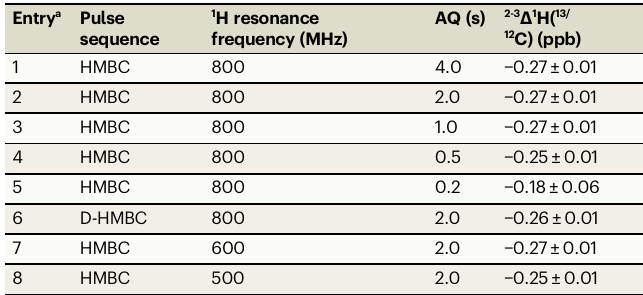
Table 1 | 2-3 Δ 1 H( 13/12 C) measurements of EtOAc at natural iso- tope